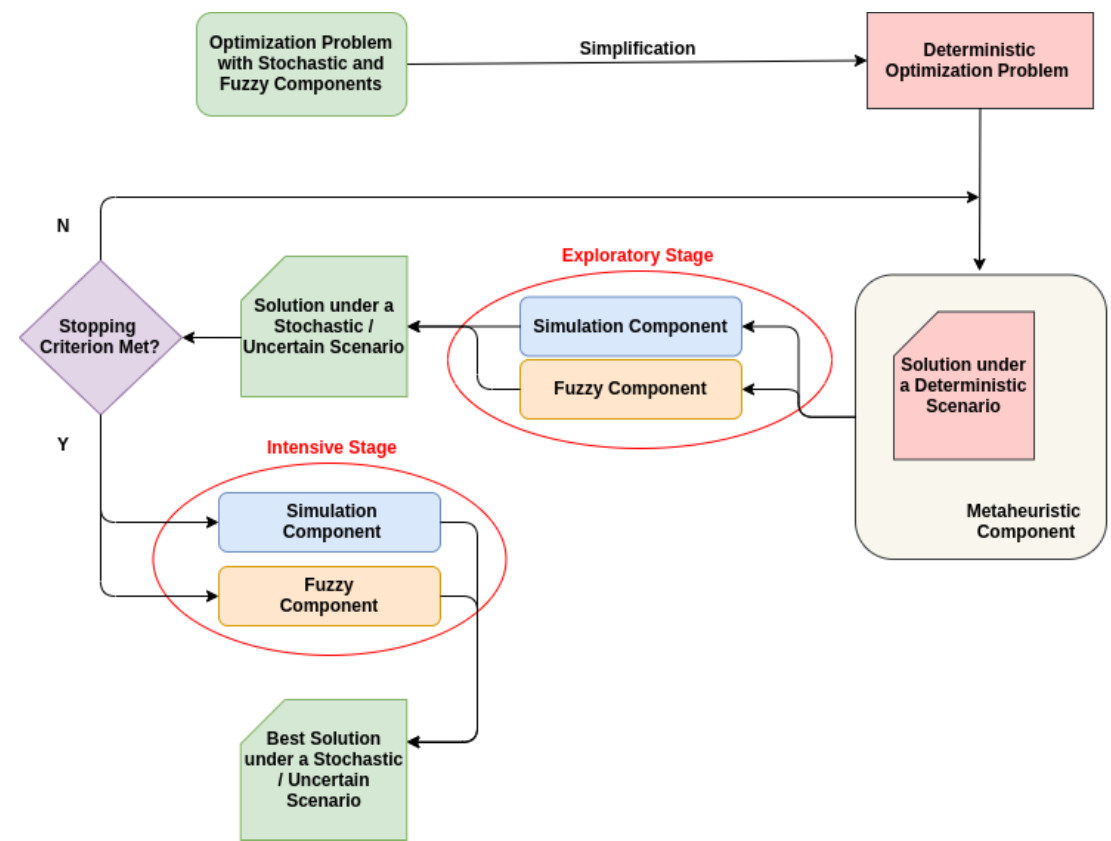
Figure 3. Schema of the extended fuzzy-simheuristic